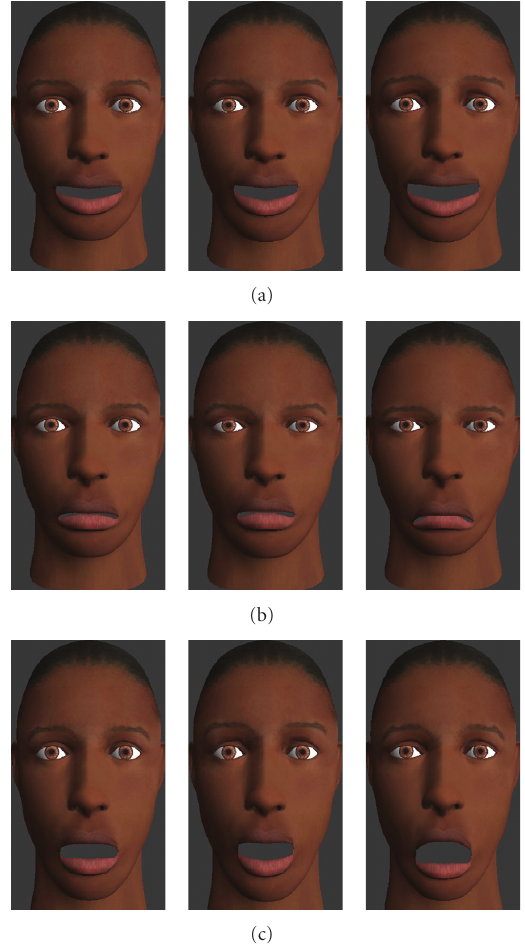
Figure 7: Example of EU-based facial expressions. Rows 1 to 3 correspond to Stories 1 to 3, and from left to right images are based on average participant input, EU method, and weighted average of activated